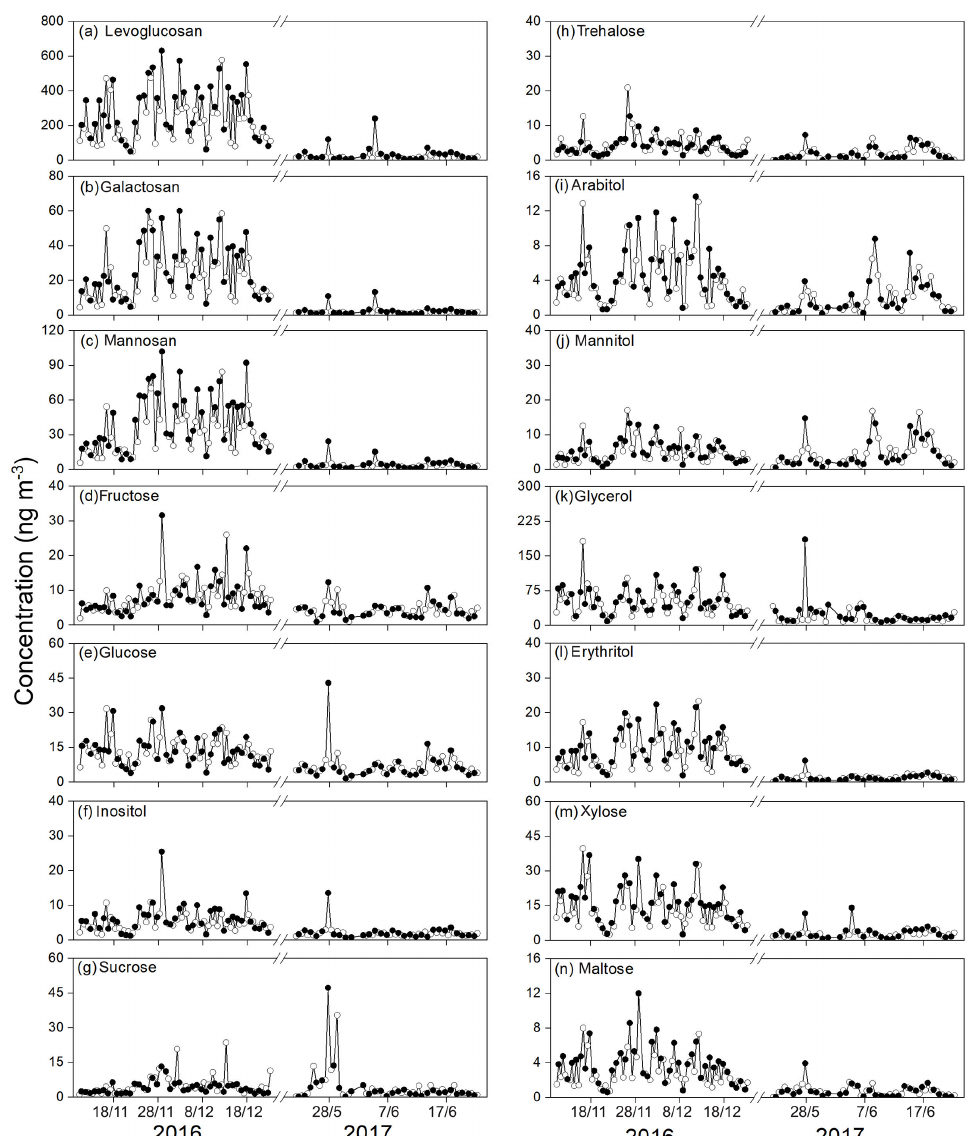
Figure 7. Temporal variations in the concentrations of saccharides detected in Tianjin aerosols (white and black represent day- and night-time